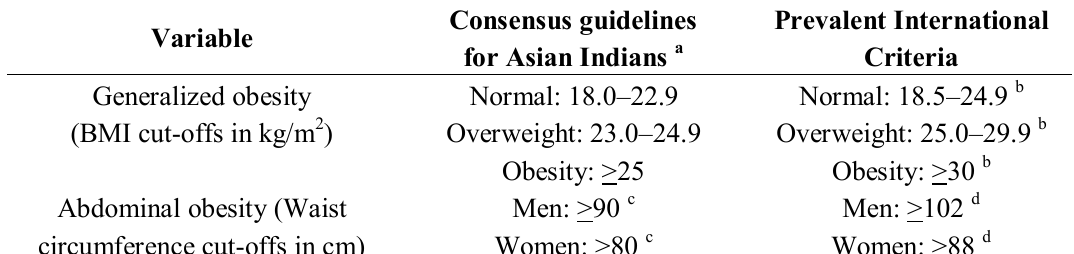
Table 1. of and international criteria.